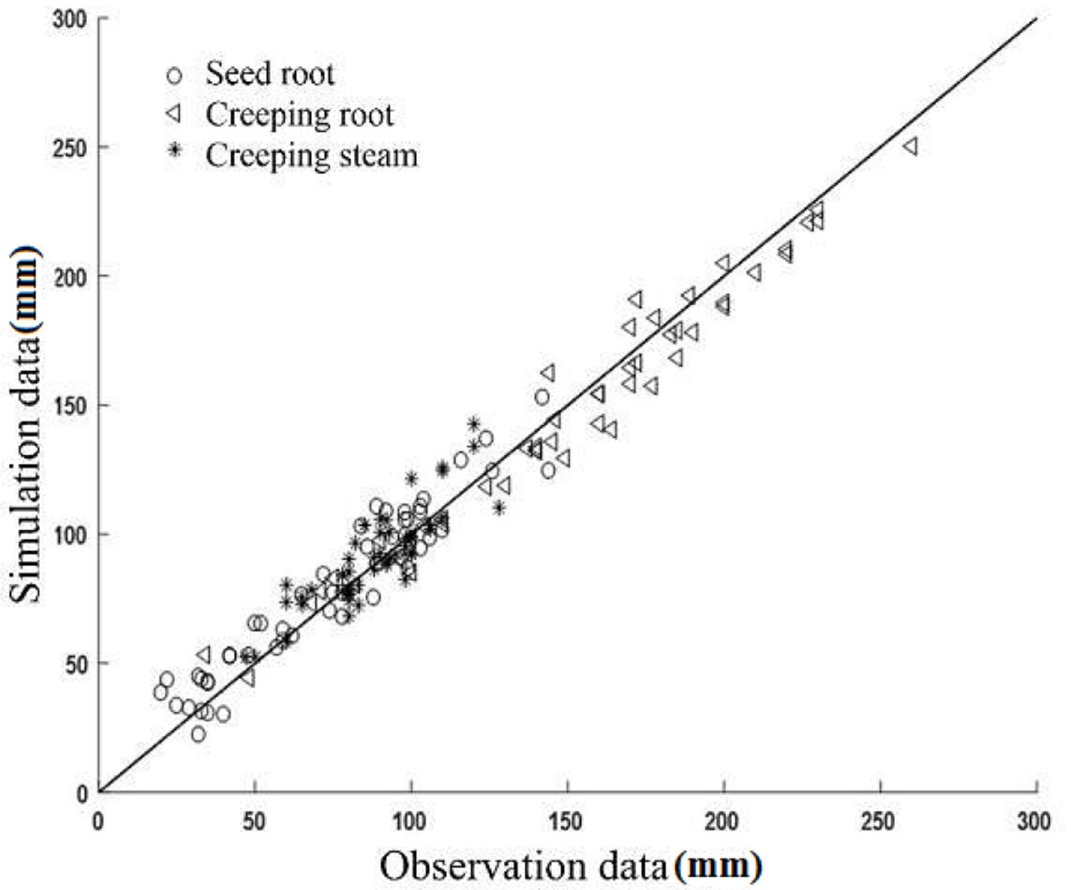
Fig 20. Comparison of measured and simulated values of Fujin.